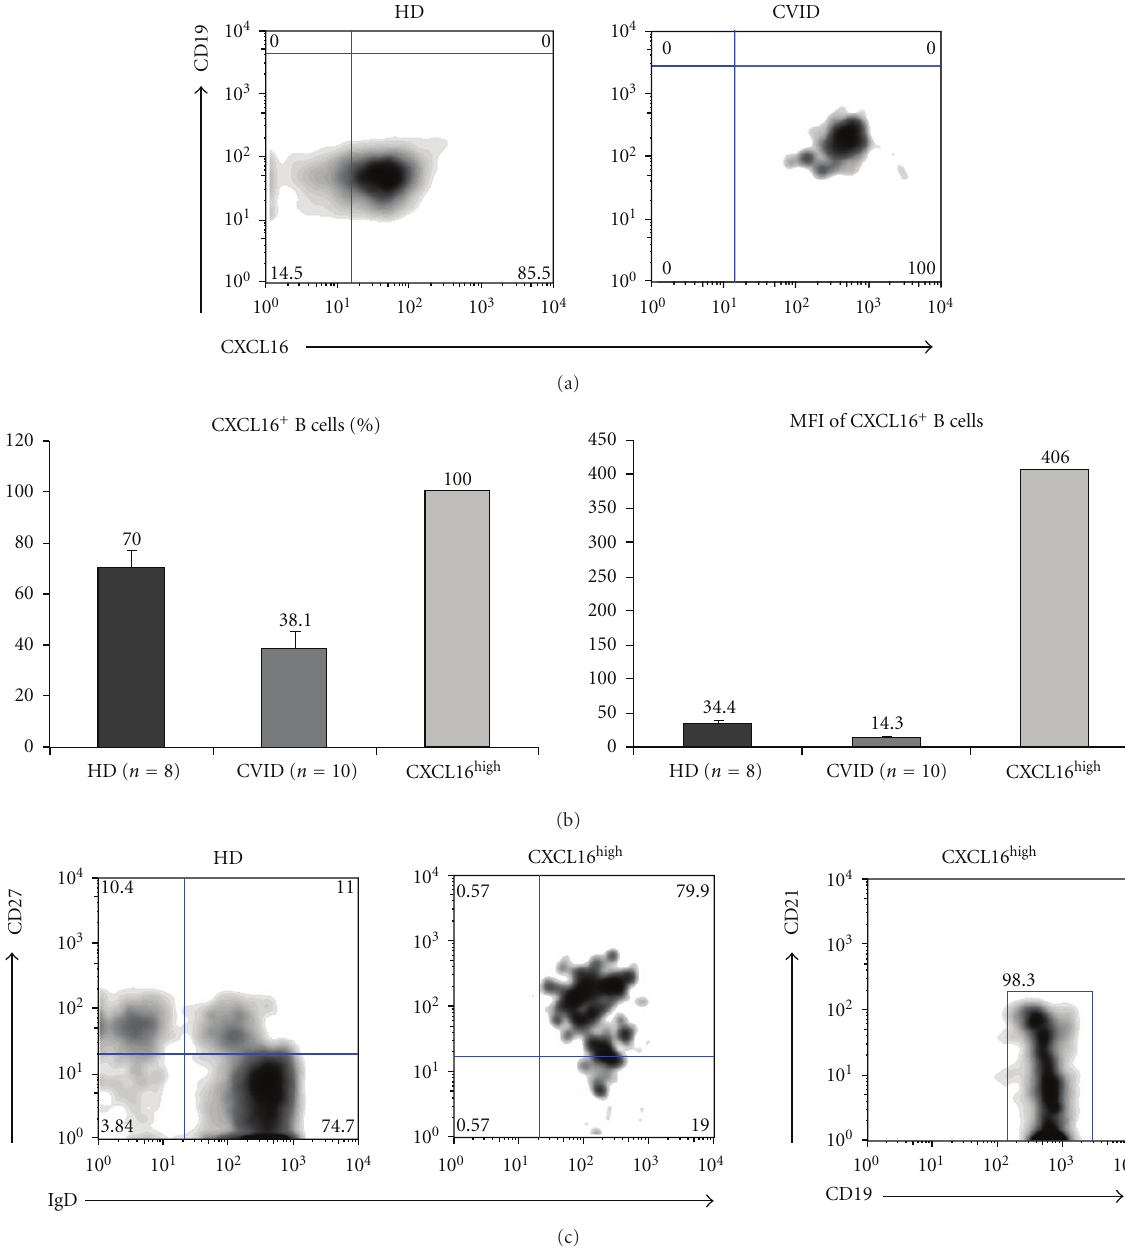
Figure 5: Identification of CXCL16 high B cells. (a) Elevated expression of CXCL16 on CVID B cells when compared to healthy control. (b) Elevated expression of CXCL16 on CVID B cells when compared to the mean expression levels of CVID patients and healthy controls